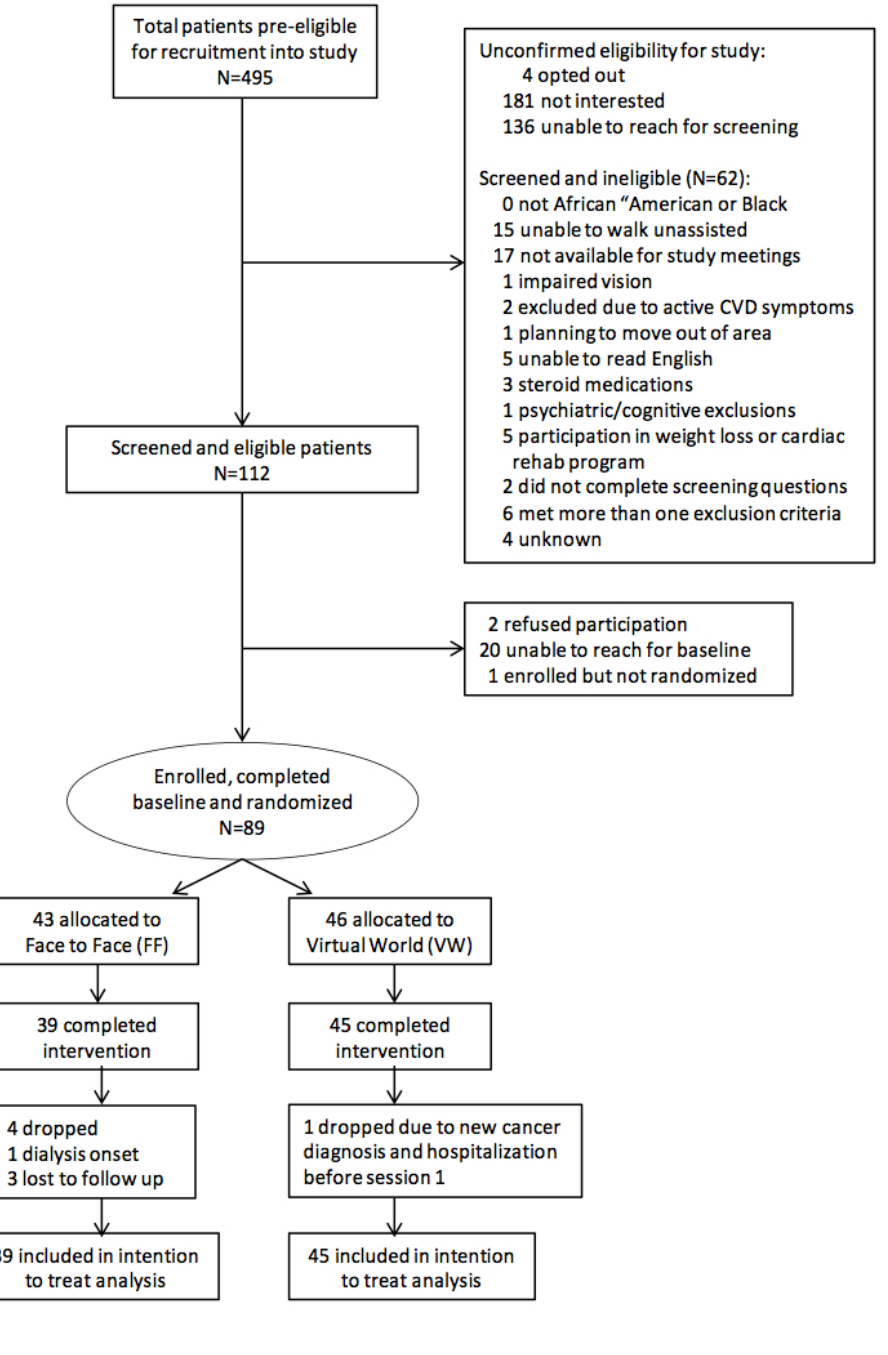
Figure 1. Flowchart of participant screening, recruitment, randomization, and